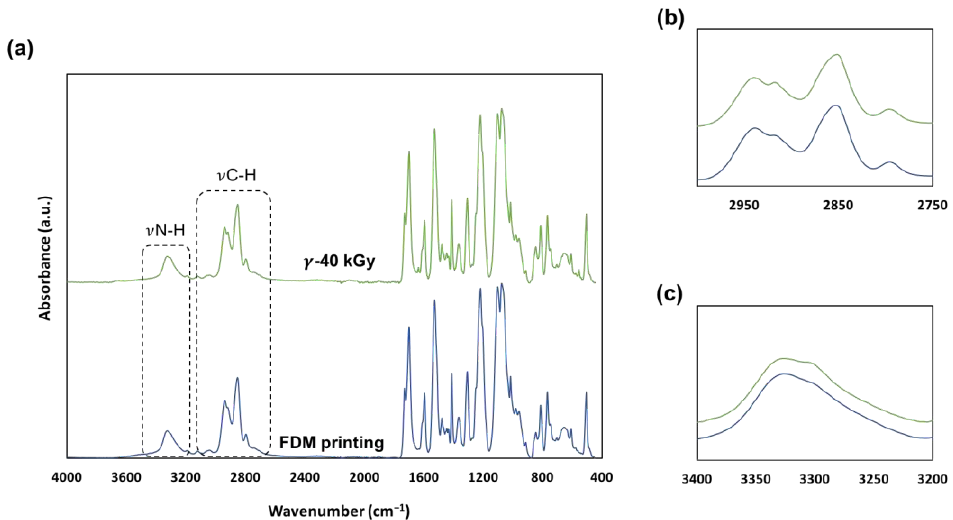
Figure 5. ( a ) ATR-FTIR spectra from 4000 cm − 1 to 400 cm − 1 of FDM processed and sterilized samples. ( b ) split at 2940 cm − 1 and shift from 2852 to 2850 cm − 1 ; and ( c ) shoulder appearance at 3300 cm − 1 .